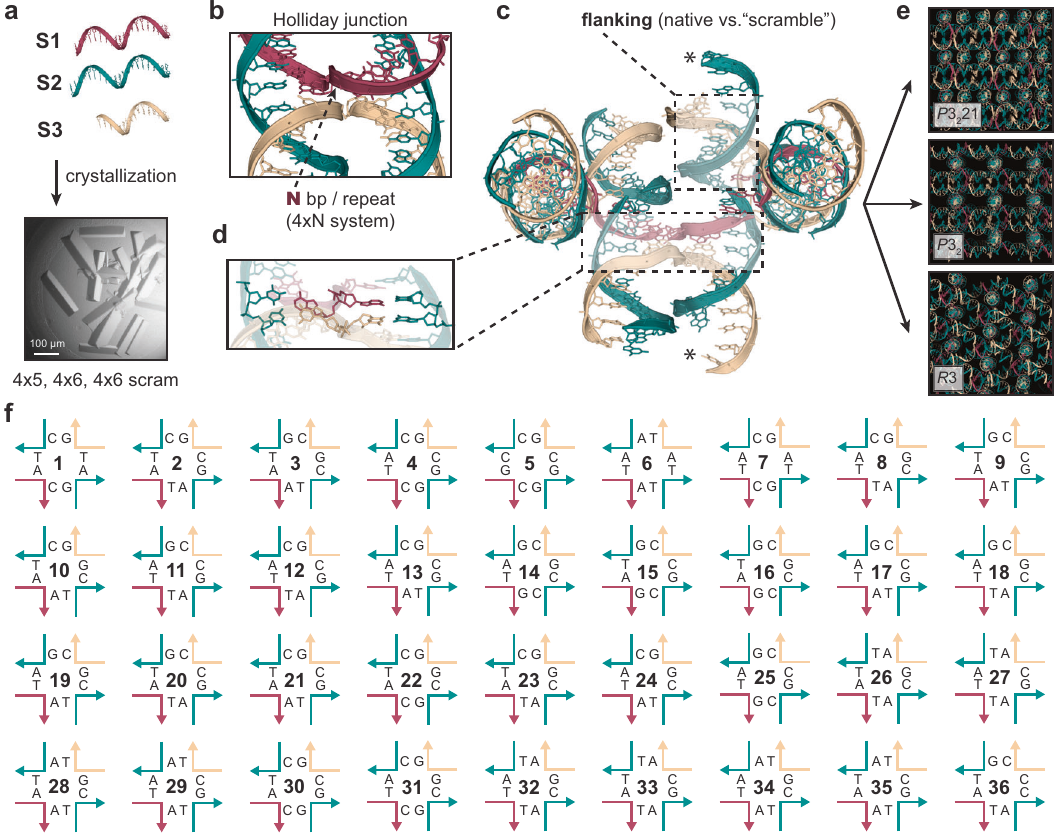
Fig. 1 Schematic of the composition of the Holliday junction which is required for the self-assembly of 3D DNA lattices. a Three oligonucleotides mediate the crystallization of two self-assembling motifs (4 × 5 and 4 × 6) along with a “ scrambled ” sequence variant. A representative example of a 3D crystal is shown. b The structure of the Holliday junction is the key building block for assembly, and contains four arms using two oligonucleotides (S1; red) and (S3; tan) serving as crossover strands, with S2 (green) serving as a third “ linear ” complementary strand on each side. The complementary region of S1 contained either fi ve or six bases (N bp) on each arm before each crossover at which point an identical sequence repeats in each consecutive arm for a total of four times (4×N) before beginning the series again (4 × 5 or 4 × 6). S1 subsequently serves as the scaffolding strand for the entire lattice. c The central building “ block ” that facilitates the 3D assembly. S1 tethers four 21-bp duplexes with the Holliday junction (boxed; translucent) at the core of the structure. The linear 21 base ssDNA oligonucleotide (S2) comprises one half of each duplex with the second crossover strand (S3) fl anking each end (boxed). Each duplex is tailed by 2 bp complementary “ sticky ends ” (asterisks) which cohere to form continuous 3D arrays. d Representative bases where sequence asymmetry was imposed to prevent “ sliding ” of the strands to create 36 immobilized junctions. e Three unique symmetries ( P 3 2 21, P 3 2 , and R 3) are dictated by the 4×N scaffolding strand working in concert with the sequence at each immobile junction. f The 36 immobile junction sequences represented in an open Holliday junction format with each strand colored in accordance with ( b ). Nucleotides on each corresponding strand are indicated with the sequence positions on each component oligonucleotide corresponding to the colored scheme in ( d